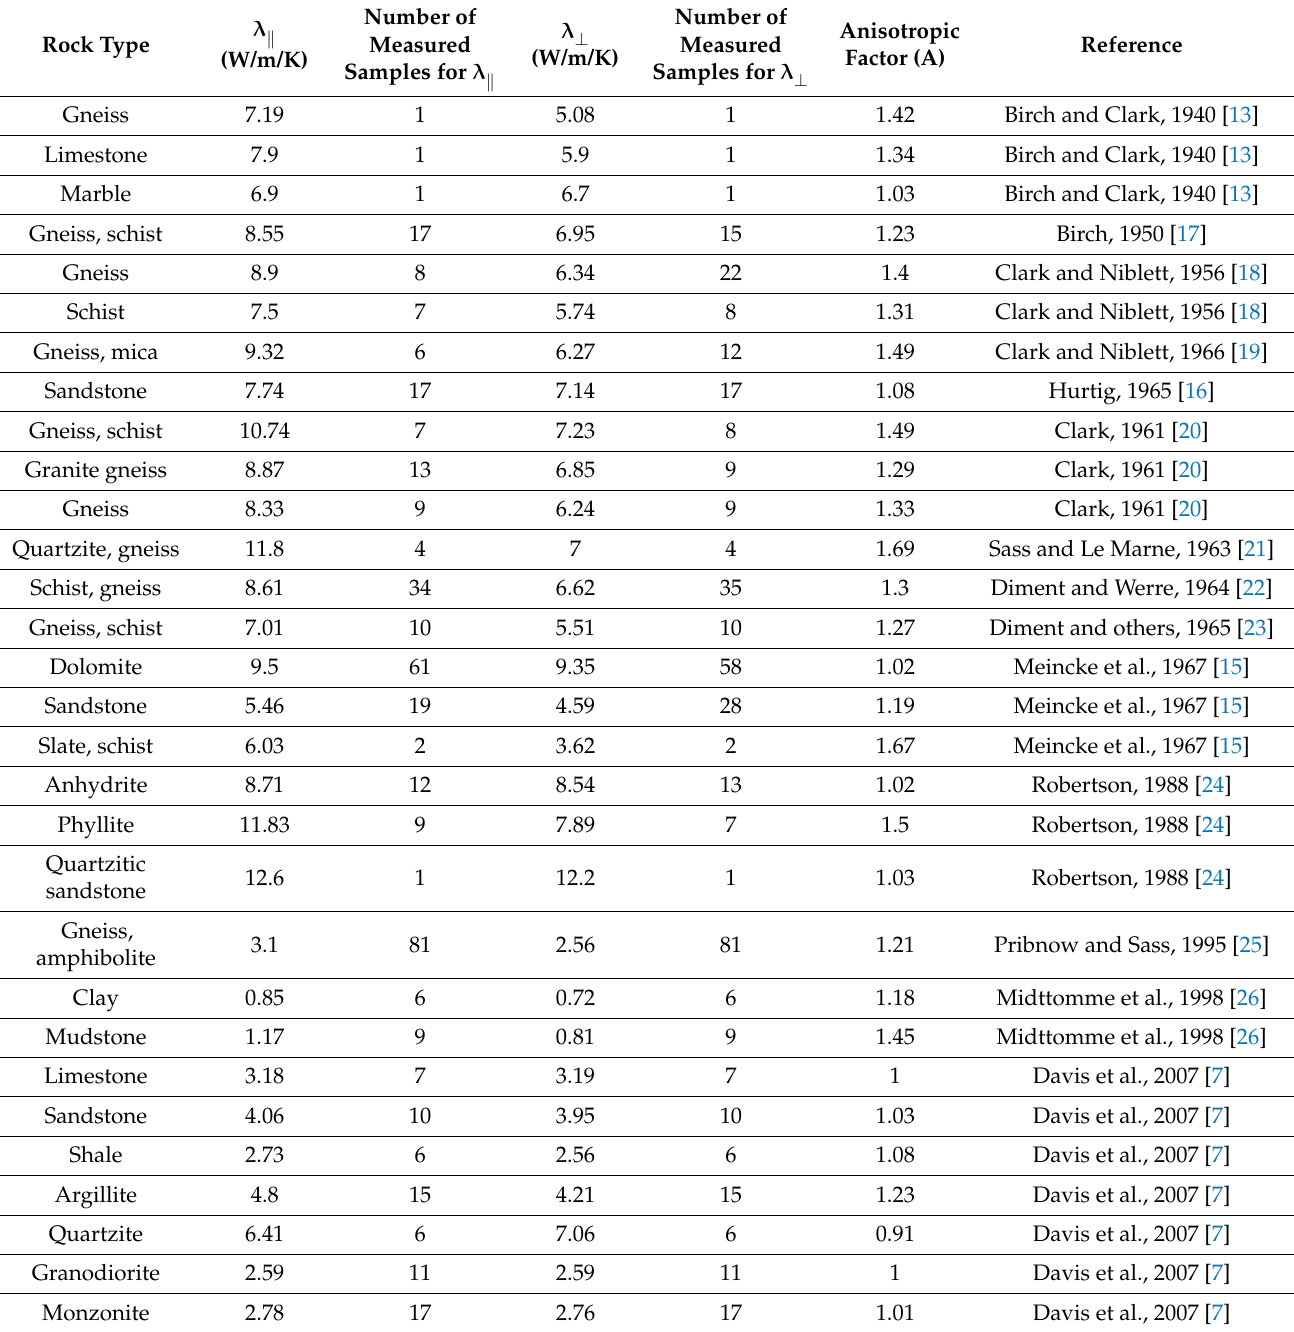
Table 2. Anisotropy of thermal conductivity of rocks in previous